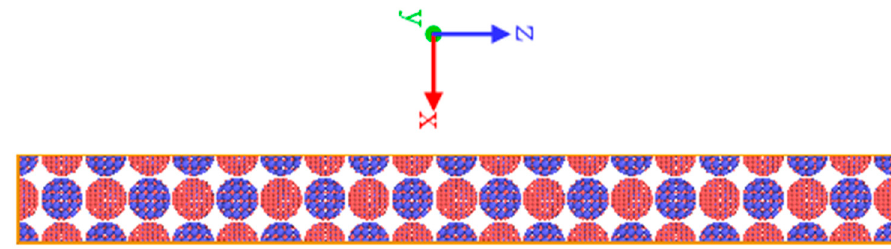
Figure 4. “Momentum mirror” impact model.